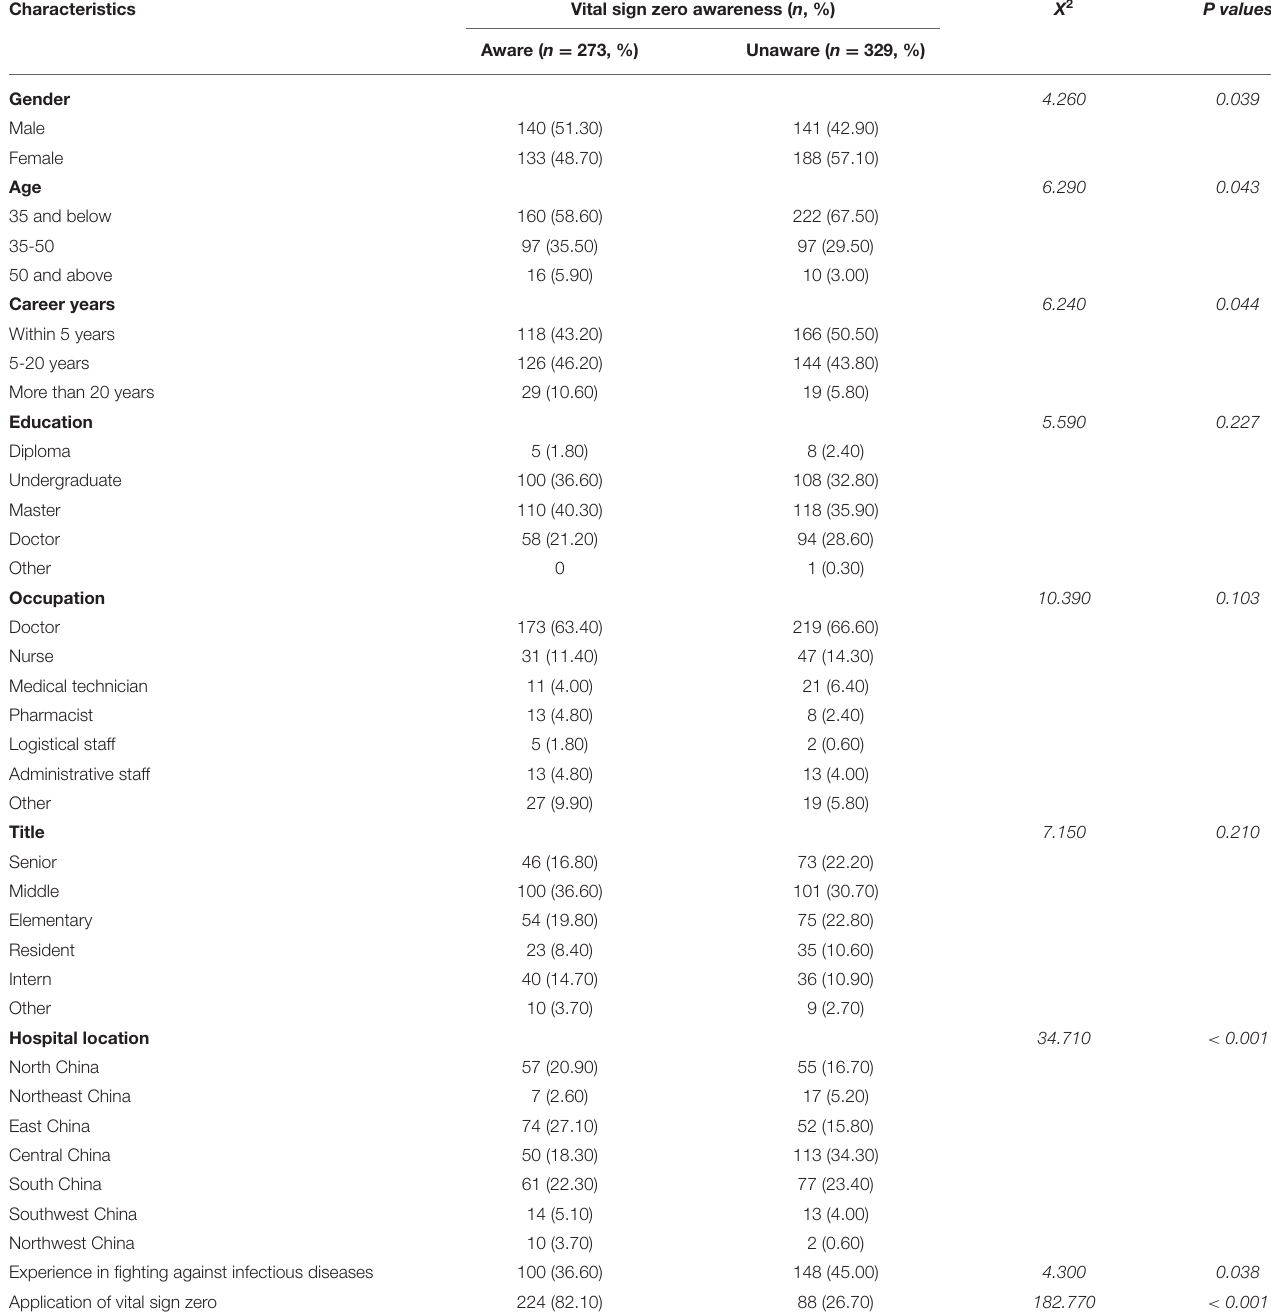
TABLE 3 | Knowledge about vital sign zero among health care workers during COVID-19 pandemic.